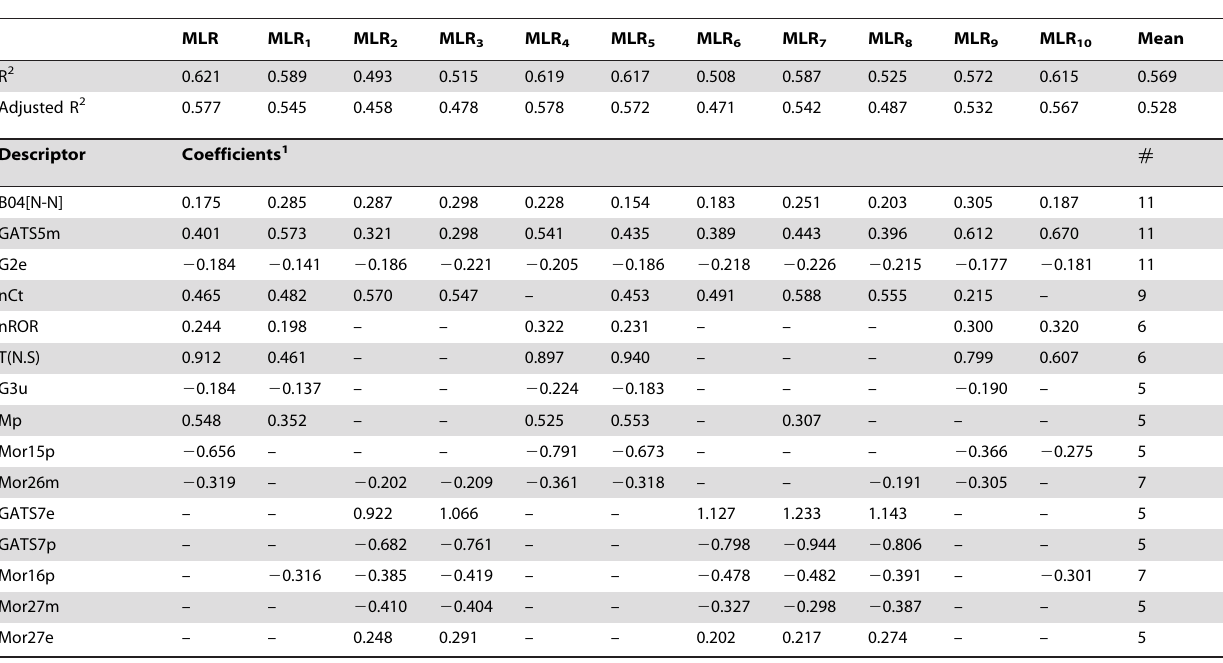
Table 4. Overview of the most robust descriptors influencing the CP-responses in the 11 MLR-models.